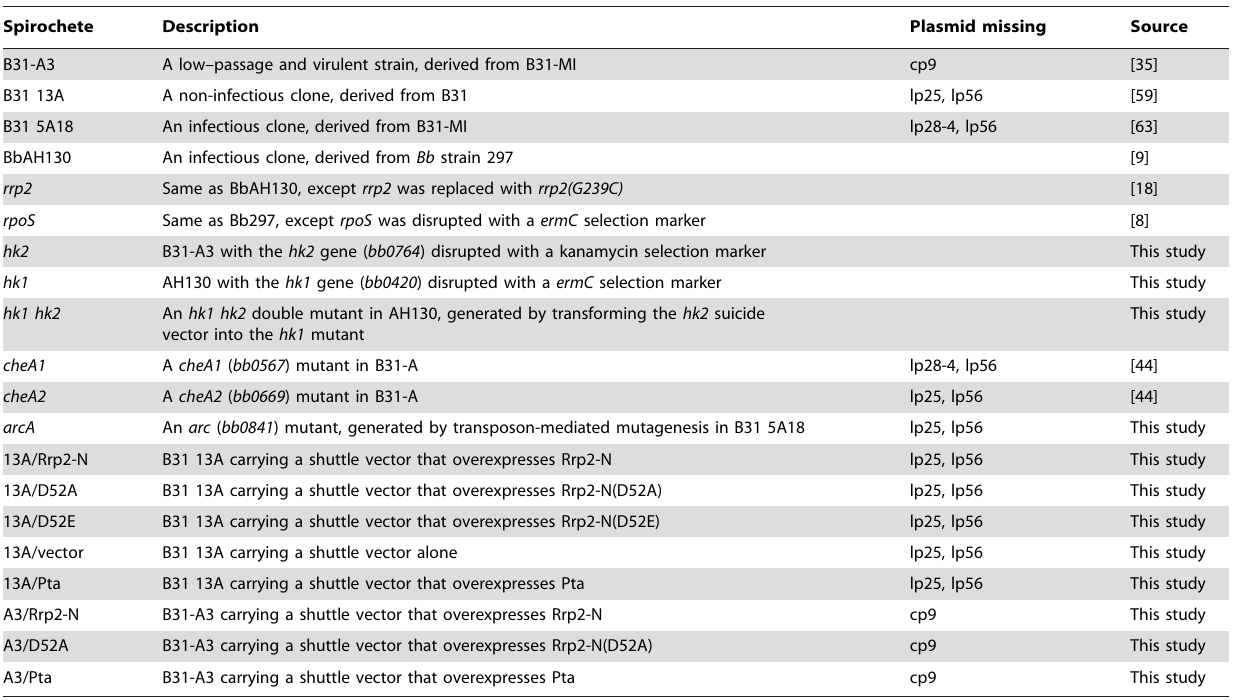
Table 1. Strain description.